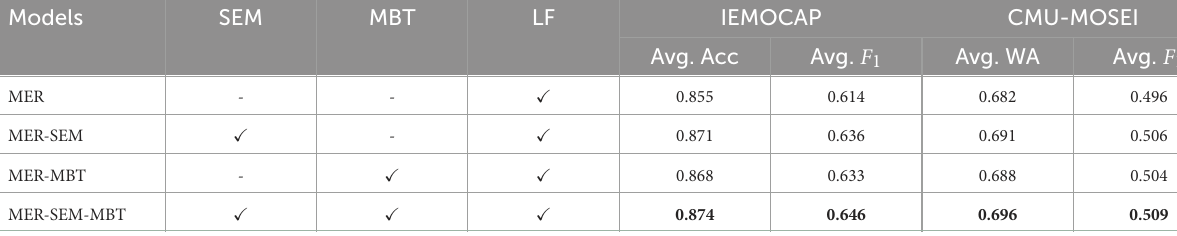
TABLE 3 Ablation study results on IEMOCAP and CMU-MOSEI datasets.